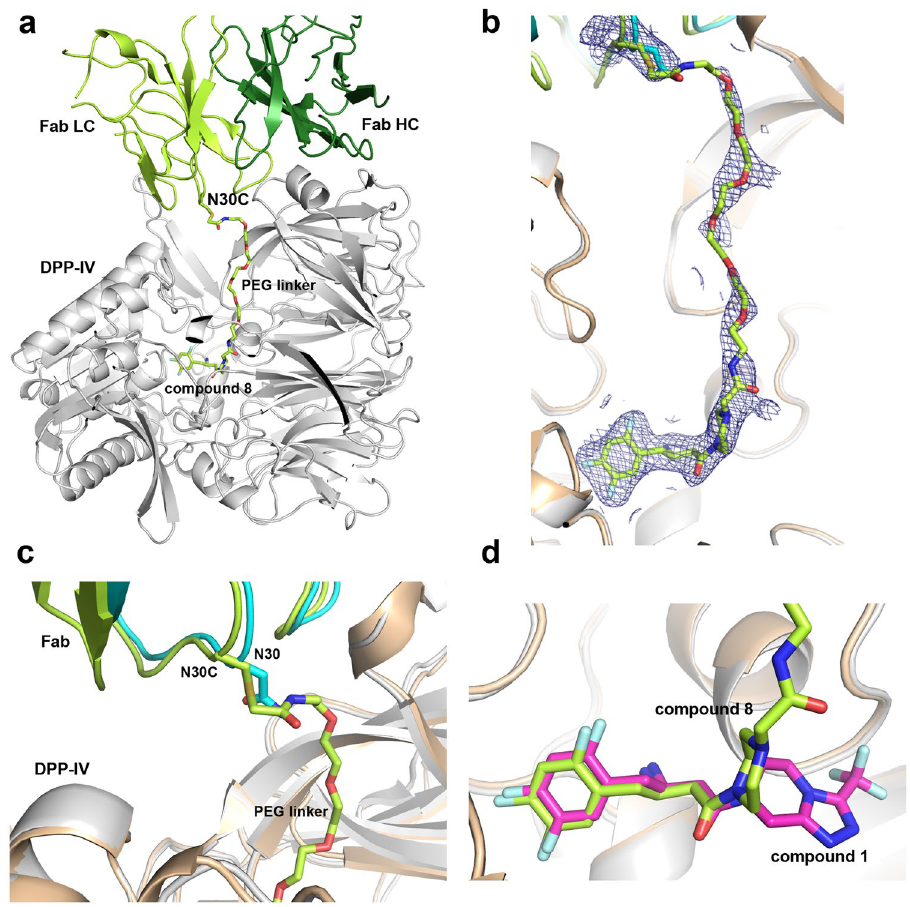
green) and heavy chain (forest green), and chemically linked SM (green carbons, red oxygens, blue nitrogens, cyan fluorines). ( b ) Electron density of SM and linker. Blue mesh, 2fo-fc map contoured at 1.0 sigma. ( c ) Close-up of conjugation site at N30C of 11A19 Fab light chain, overlaid with the ternary complex structure (4FFW) of DPP-IV (beige) with 11A19 Fab (light chain in cyan). ( d ) Superposition of the SM portion of the hybrid (compound 8 ) (green) and sitagliptin (compound 1 )